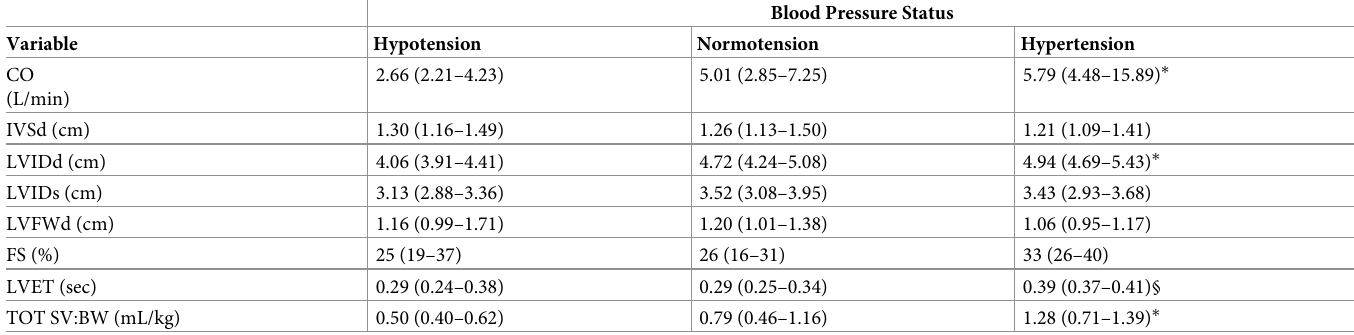
Table 3. Median (min-max) values for hemodynamic variables measured with ECHO in six, isoflurane anesthetized, mature alpacas during isoflurane induced hypotension, normotension and phenylephrine infusion (0.5–3 mcg/kg/min) induced hypertension. Hypotension was defined as a mean blood pressure between 45 and 55 mmHg, normotension was defined as a mean blood pressure between 65 and 75 mm Hg and hypertension was defined as a mean blood pressure greater than 85